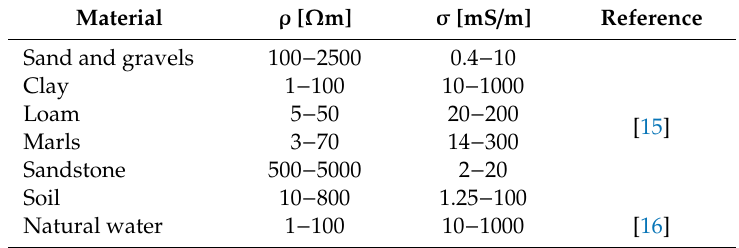
Table 1. Resistivity ( ρ ) and conductivity ( σ ) of various materials and water combined from di ff erent sources.